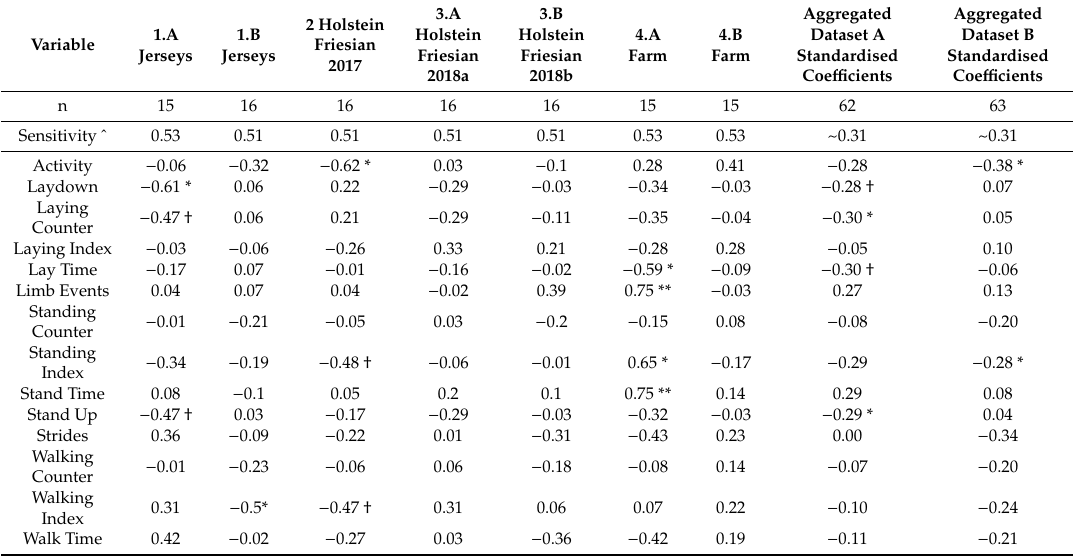
Spearman’s Rho correlation and standardized coe ffi cients of behavior measures to mobility